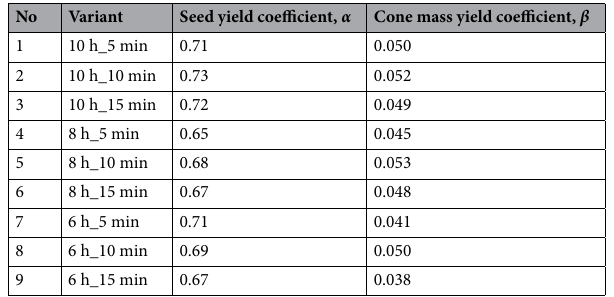
Table 8. Seed yield coefficient and cone mass yield coefficient for each process variants.